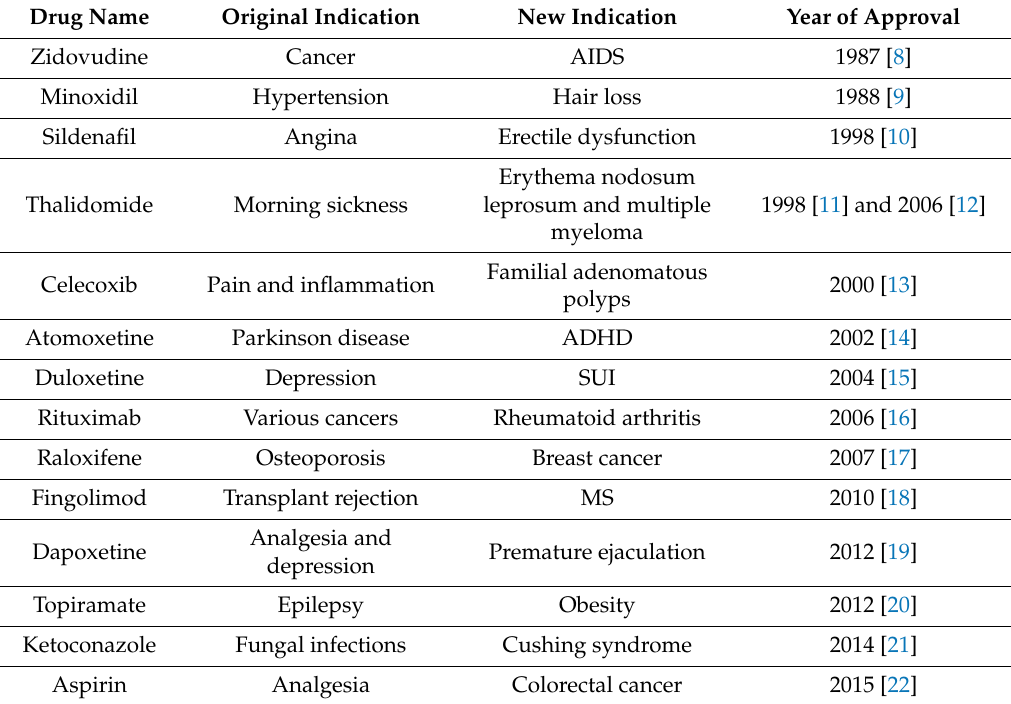
Table 1. Overview of selected successful drug reprofiling